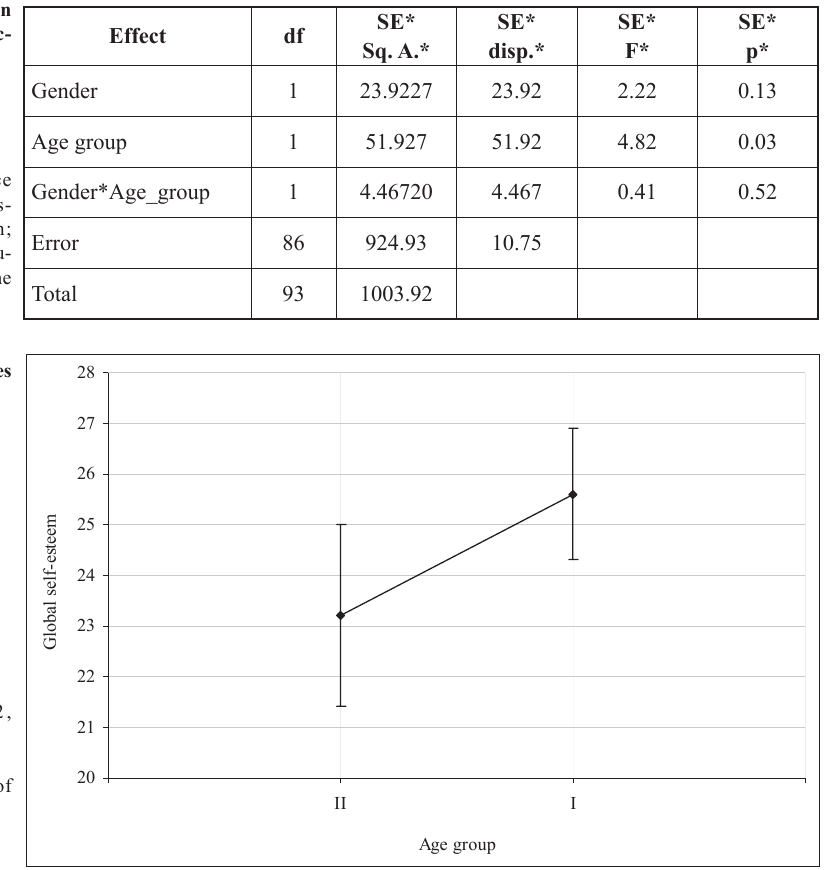
Note. Wilksov lambda = 0.89622, F (11.76) = 0.80009, p = 0.63946. Decomposition of effective hypothesis. Vertical column indicates 0.95 interval of